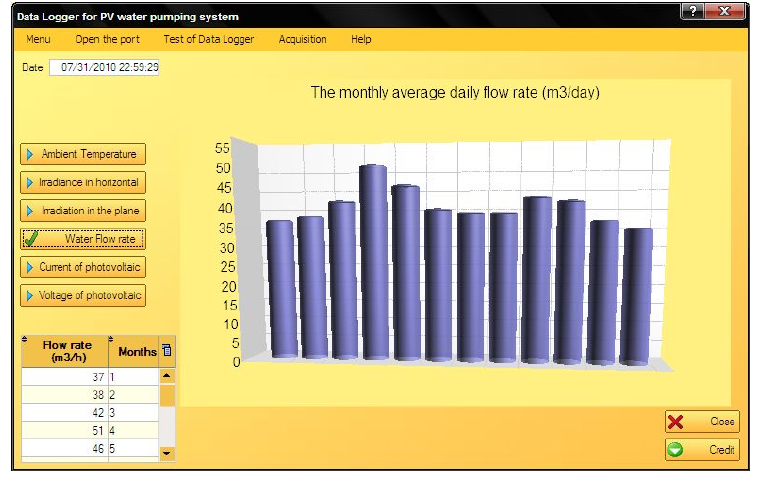
Figure 9. Interface of the data acquisition software.